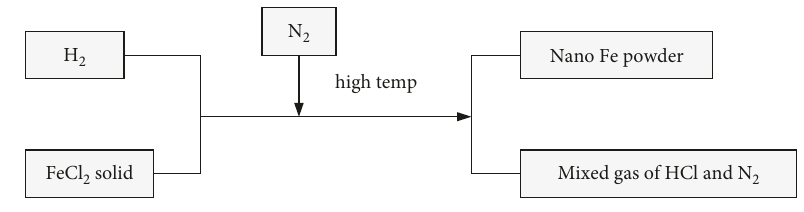
Figure 3: Nanofabrication